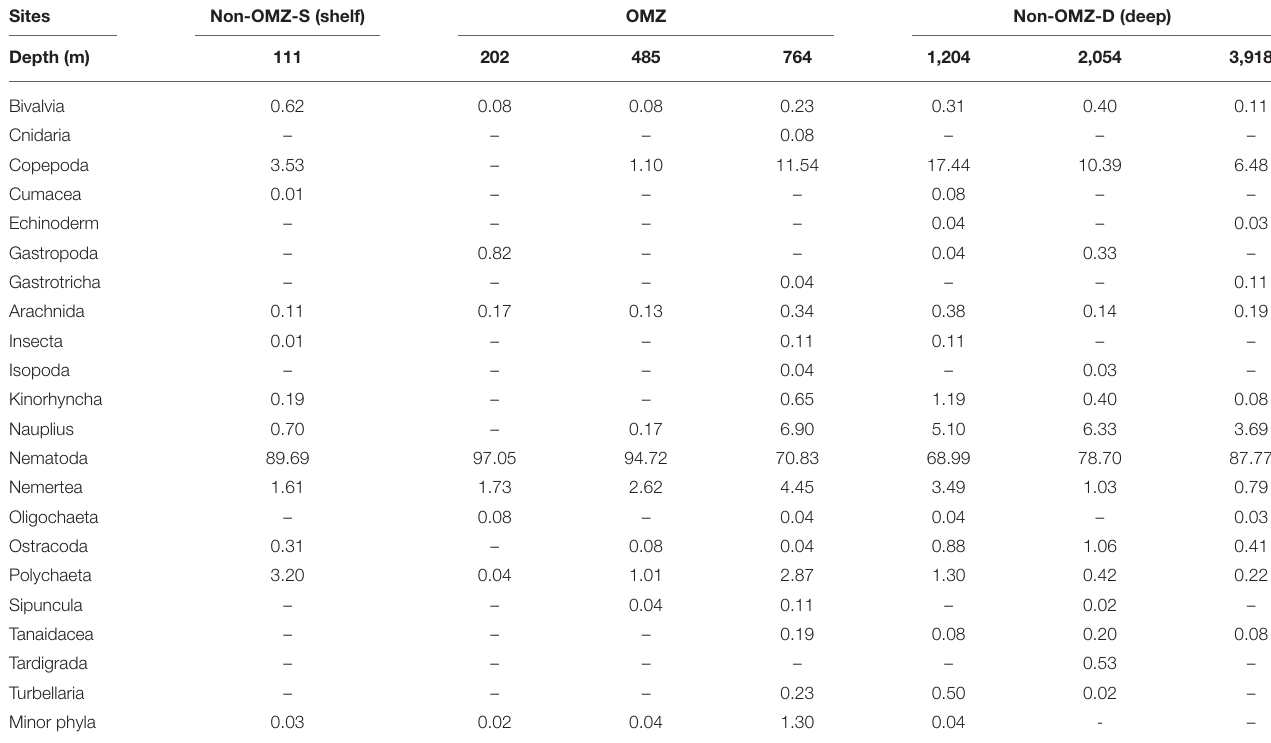
TABLE 2 | Relative percentage abundance (%) of meiofaunal taxa at seven sites sampled along the Western Indian Continental Margin (WICM) and abyssal plain.